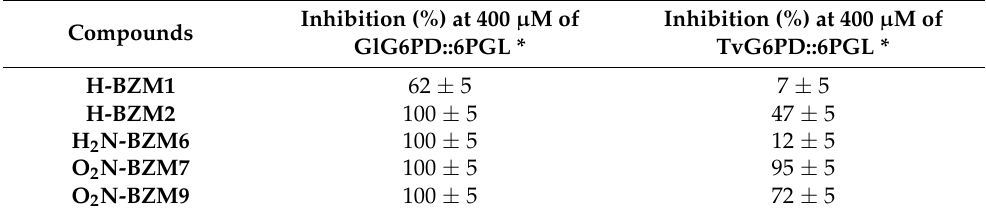
Table 1. Percentage of enzyme activity of GlG6PD::6PGL and TvG6PD::6PGL after incubation at 37 ◦ C for 2 h with benzimidazole derivative compounds of 400 µ M. Inhibition (%) at 400 µ M of Inhibition (%) at 400 µ M Compounds GlG6PD::6PGL *